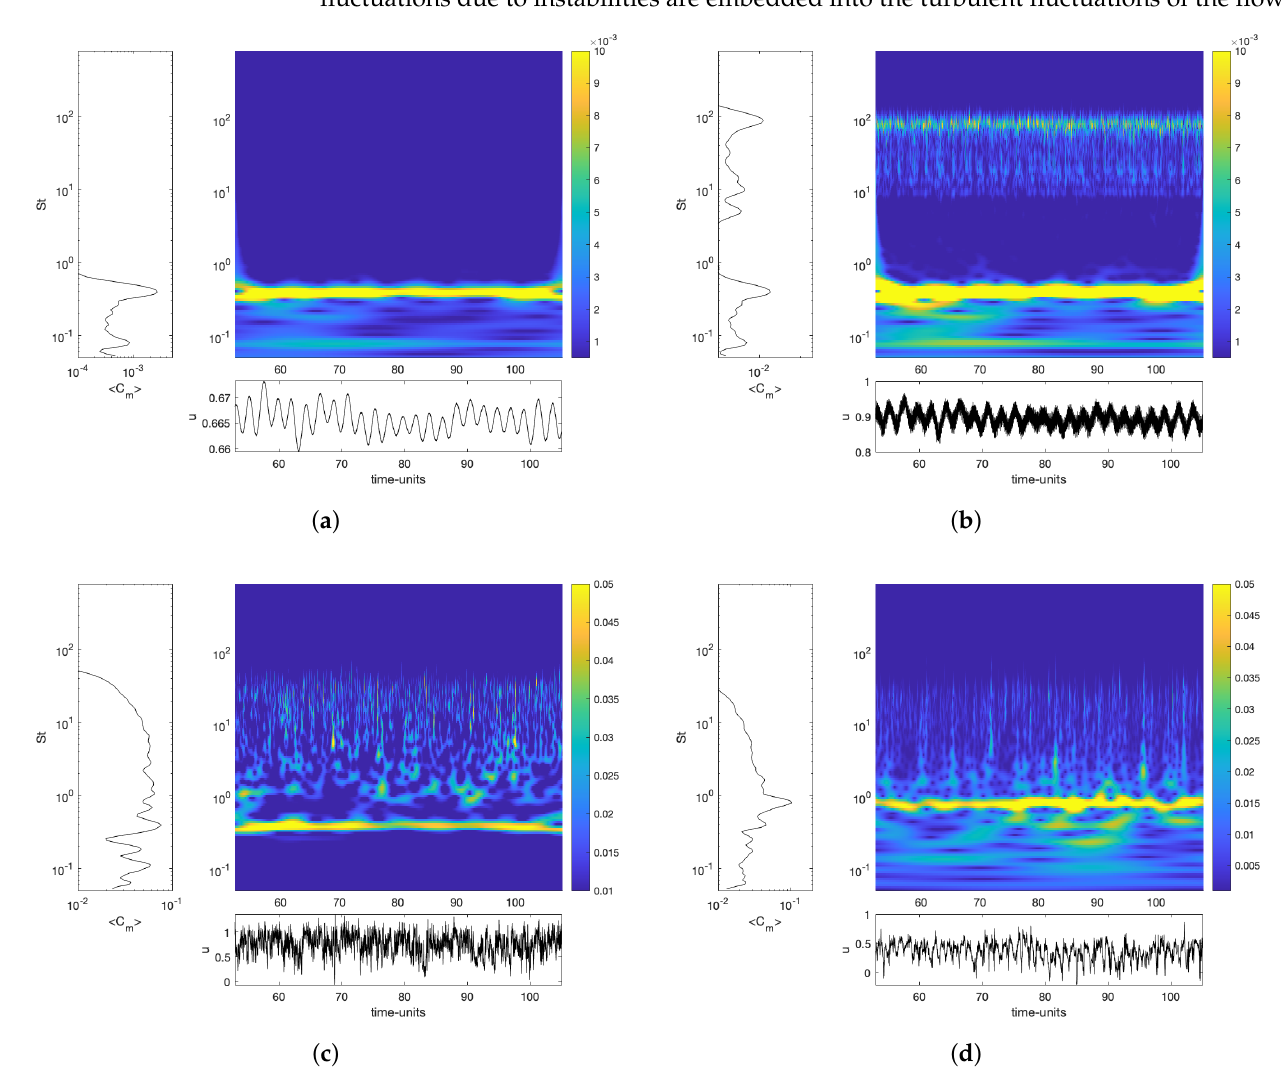
Figure 13. {Time–frequency} analysis using the continuous wavelet transform of the streamwise velocity component at different locations. ( a ) Cylinder boundary layer at 70 ◦ from the front stagnation point; ( b ) cylinder boundary layer at 90 ◦ from the front stagnation point; ( c ) in the separated shear layer at ( x / D , y / D ) ∼ ( 0.6,0.33 ) ; ( d ) at the wake centerline at ( x / D , y / D ) ∼ ( 1.3,0 )